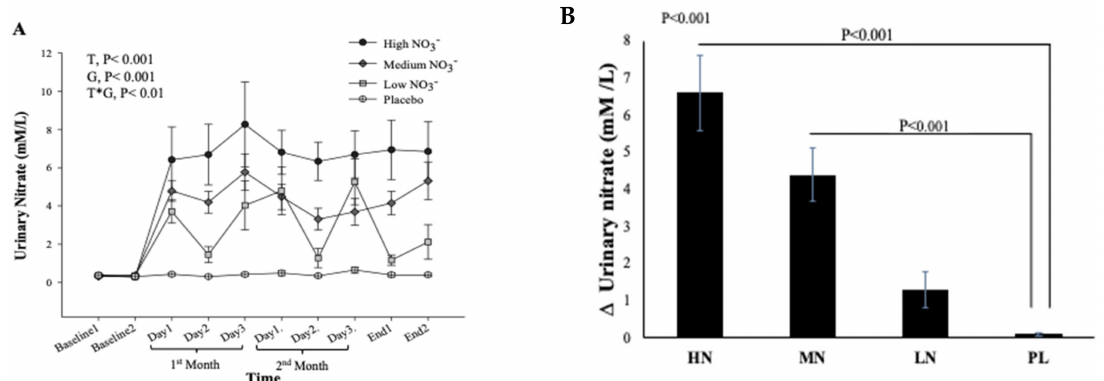
Figure 7. Urinary NO 3 − concentrations in older overweight and obese adults. ( A ) Mean urinary NO 3 − concentrations measured at baseline, 4 weeks, 8 weeks, and after 13-weeks for each of the intervention groups. ( B ) The Mean of the change in urinary NO 3 − concentrations between baseline and week 13 for each of the intervention groups. HN (High NO 3 − ; two 70 mL shots of BJ/day, morning and evening), MN (Medium NO 3 − ; 70 mL of BJ/day), LN (Low NO 3 − ; 70 mL of BJ every alternate days) and PL (placebo; 70 mL of NO 3 − depleted BJ). Each shot of BJ contains 400 mg of NO 3 − . ( A ) Data were analysed using a 2-factor repeated measures ANOVA (time*group of intervention). ( B ) These changes from baseline were analysed with one-way ANOVA. Data are expressed as mean ± SEM, ( n = 50).